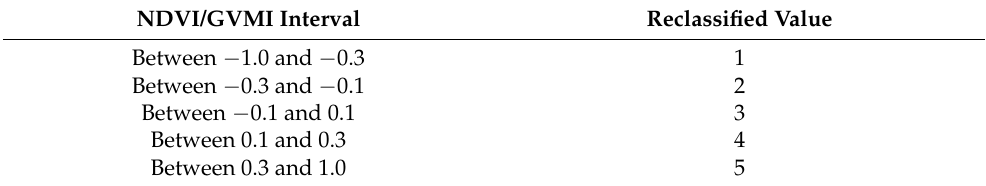
Table 5. Precipitation classification. Precipitation Interval (mm) Reclassified Value Between 0 and 400 1 Between 400 and 500 2 Between 500 and 600 3 Between 600 and 700 4 Between 700 and 800 5 Between 800 and 1000 6 Between 1000 and 1200 7 Between 1200 and 1400